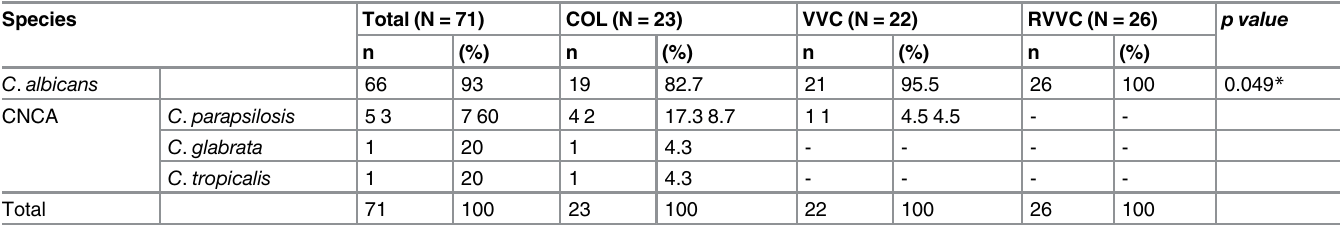
Table 2. Relative distribution of Candida albicans and Candida non- C . albicans species according to the clinical profile.